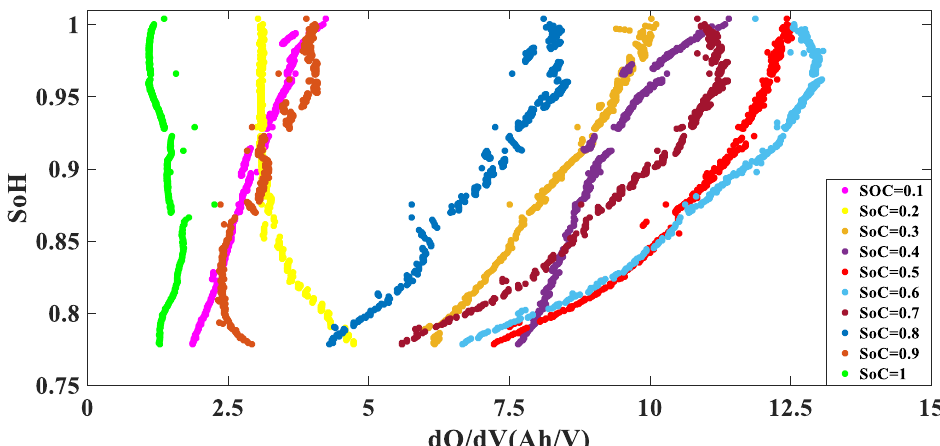
Figure 3. The relationship between SoH and dQ / dV at 10 different SoCs (the SoC interval is 0.1 and dV = 0.02 V).